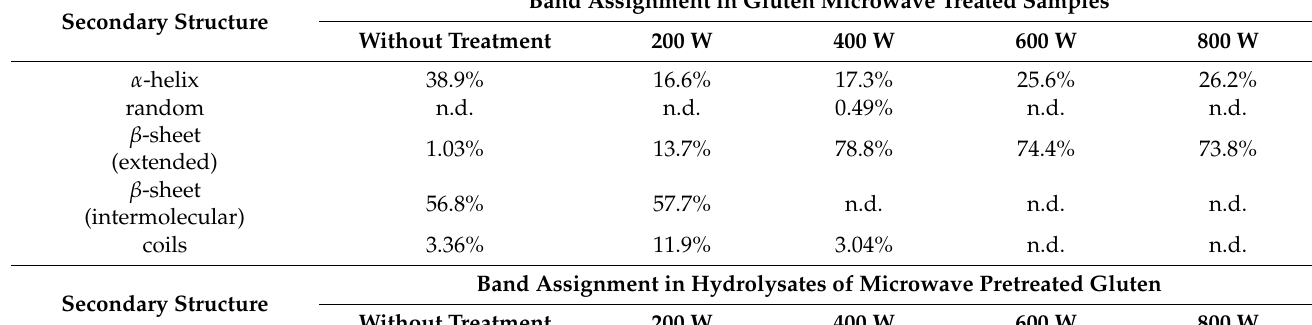
Table 1. Secondary structure band assignments in the gluten protein samples pretreated with microwaves and in their